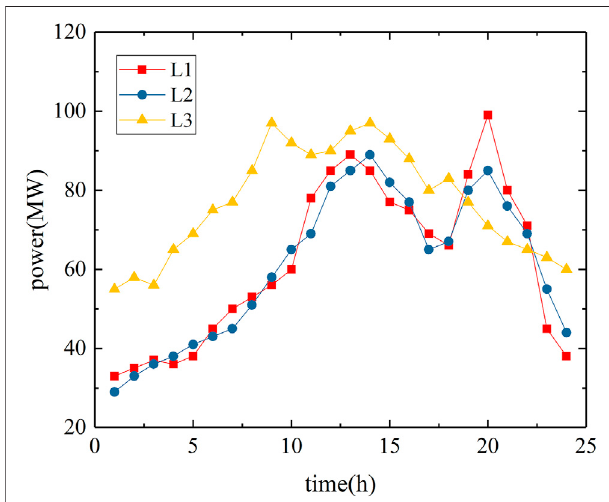
FIGURE 3 | Typical daily load demand curve of each node.